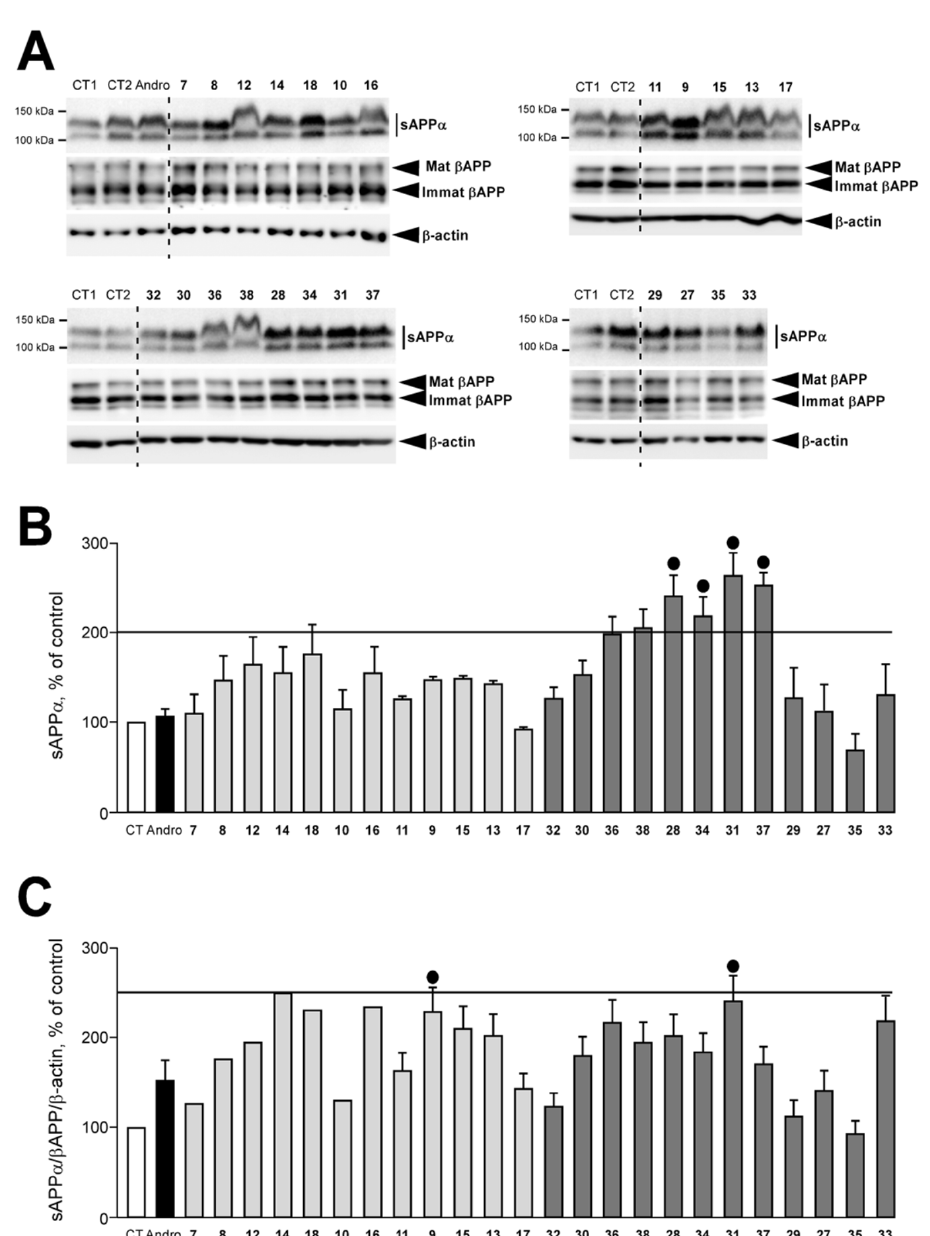
Figure 1. Screening of andrographolide and andrographolide derivatives for sAPP α secretion, β APP protein levels, and the ratio sAPP α / β APP in SH-SY5Y cells. ( A ) illustrates the Western blot analysis of the screening. Bars in ( B ) (sAPP α production) and ( C ) (ratio of sAPP α to β APP normalized with β -actin) correspond to the densitometric analyses, are expressed as a percentage of control (white bars, non-treated cells) and are the average of the comparison with two controls. The black circles indicate compounds selected for further characterization. The hatched black line in (A) indicates a splicing of the original gels.